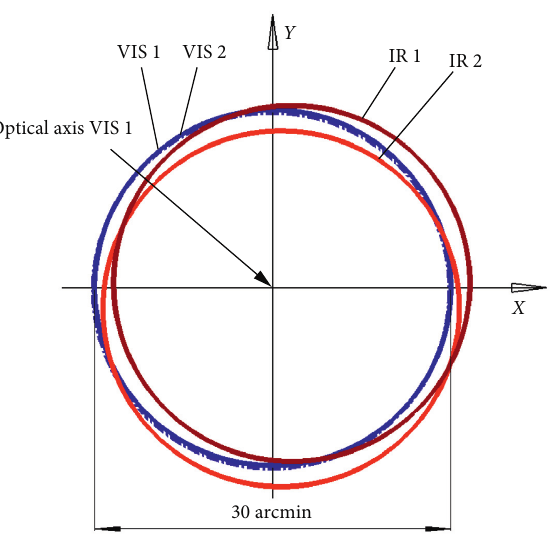
Figure 10: Position of optical axis input telescope VIS-1, 2 and IR-1, 2. Table 5: Divergence value of optical axis of the input telescope system VIS-1, 2 and IR-1,